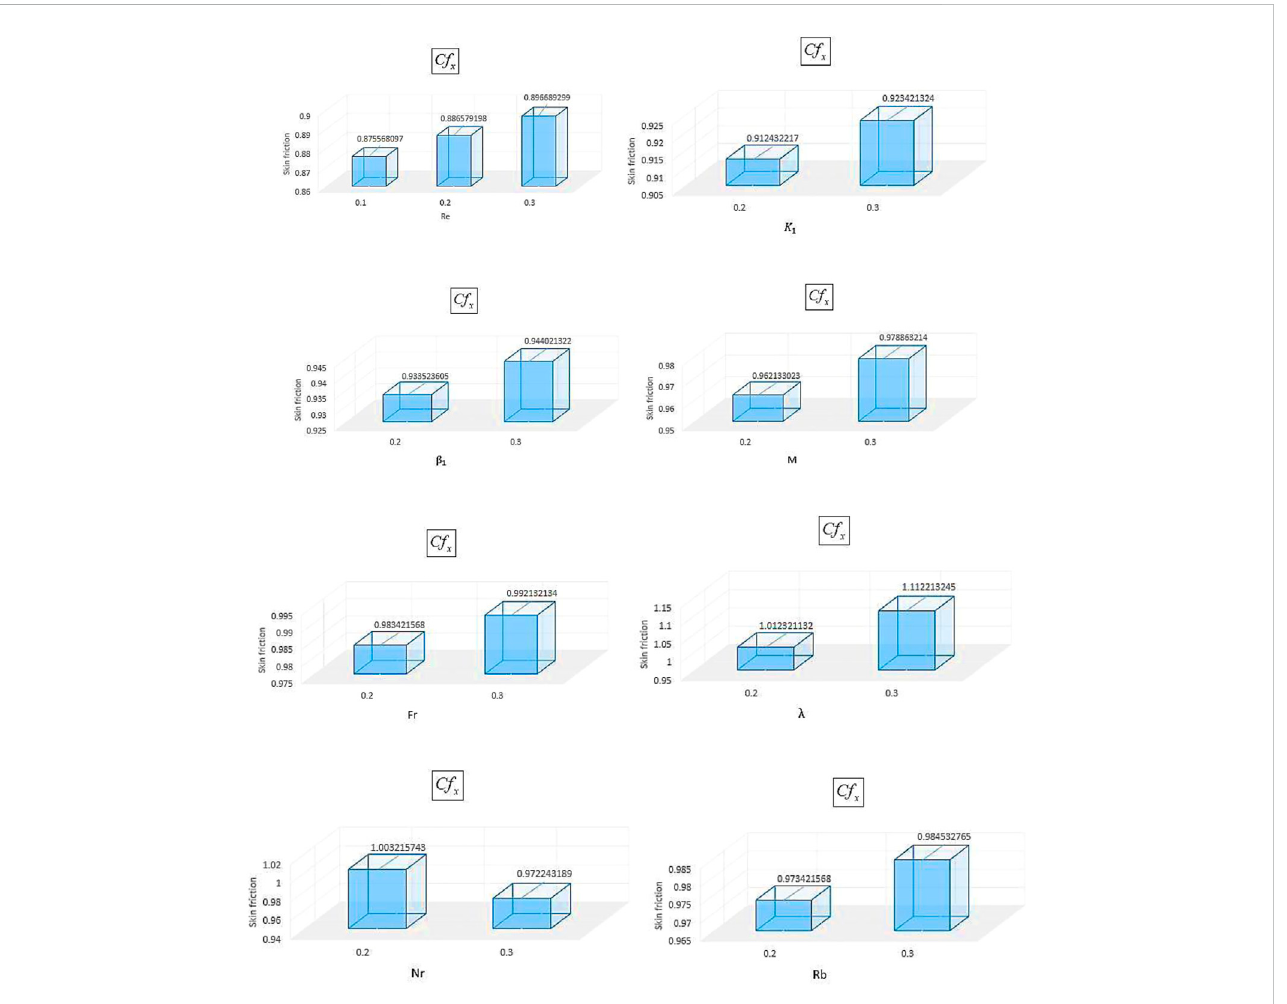
up with enhancing values of N r . Hence, the velocity pro fi le grows up for higher values of N r . Figure 3A portrays the in fl uence of N b upon the thermal pro fi le. Physically, when the values of N b increase higher, then the haphazard fl ow of fl uid particles also increases for which the collision among the fl uid particles increases. In this phenomenon, kinetic energy of the fl uid particles is changed to thermal energy, which results ultimately in augmentation in the thermal characteristics of particles. The effect of the thermophoretic parameter N t upon heat fl ow is depicted in Figure 3B. From this fi gure, it has been revealed that, for an upsurge in N t , there is a higher difference in the temperature that will lead to a growth in the temperature fl ow from a warmer region to a colder region. This physical phenomenon results in augmentation in the temperature of the fl uid. Figure 3C endorses that thermal diffusion is supported by a growth in the radiation parameter R d . Physically, an augmentation in R d increases the size of the thermal boundary layer and diffuses more heat. Hence, the higher values of R d provide maximum temperature to the fl ow system. Figure 3D illustrates the effect of Reynolds number Re on the thermal pro fi le. It is obvious from this fi